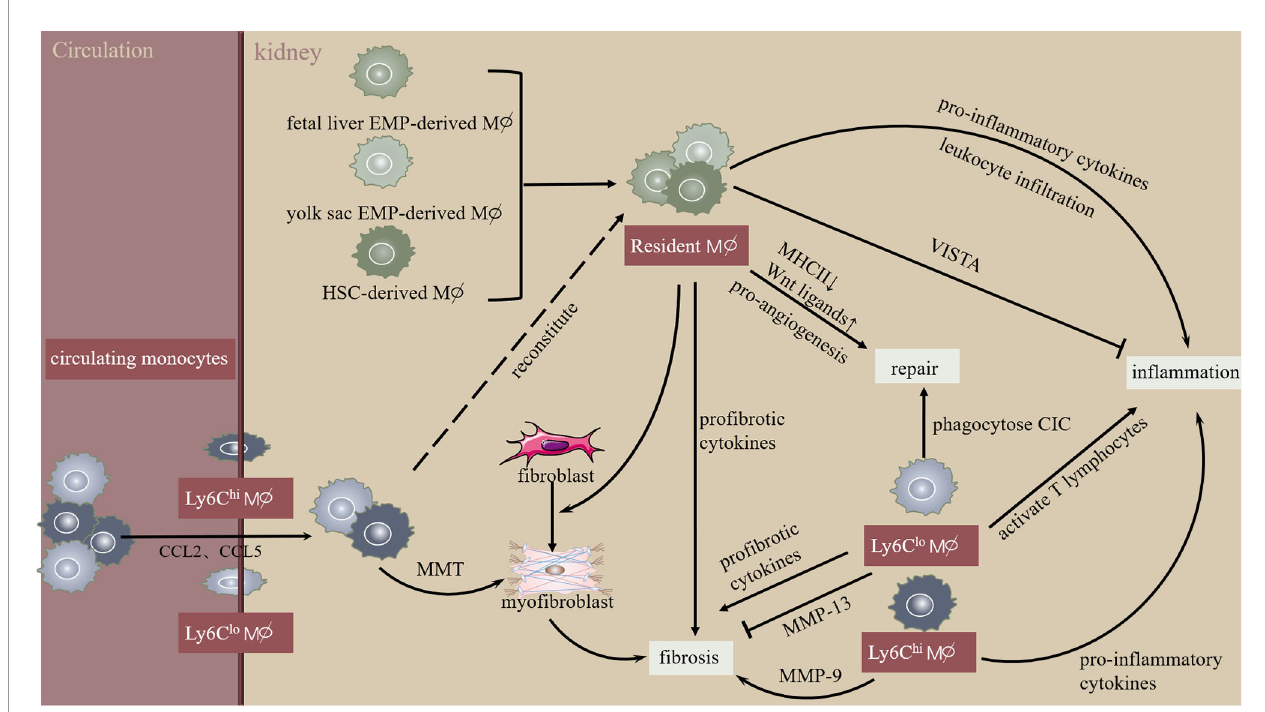
FIGURE 1 | Macrophage heterogeneity during initiation and progression of kidney injury and fi brosis. Kidney resident macrophages derive from multi-sources and monitor trans-endothelial transport of circulating immune complexes. In the initial phase of kidney injury, resident macrophages stimulate leukocyte in fi ltration and cytokine secretion. Interestingly, kidney resident macrophages express V-domain Ig suppressor of T cell activation (VISTA), an inhibitory immune checkpoint molecule. Increased chemokines (CCL2, CCL5) promote circulating monocyte chemotaxis into the kidney, developing into in fi ltrating Ly-6C hi macrophages exhibiting pro-in fl ammatory phenotype or macrophage-myo fi broblast transition (MMT). Similarly, in fi ltrating Ly6C low macrophages promote kidney in fl ammation and fi brosis via activating T lymphocytes or pro-in fl ammatory cytokines. However, Ly6C hi macrophages inhibit kidney fi brosis by producing MMP-13. Overall, these mechanisms lead to extracellular matrix dynamic homeostasis during the resolution of kidney injury and fi